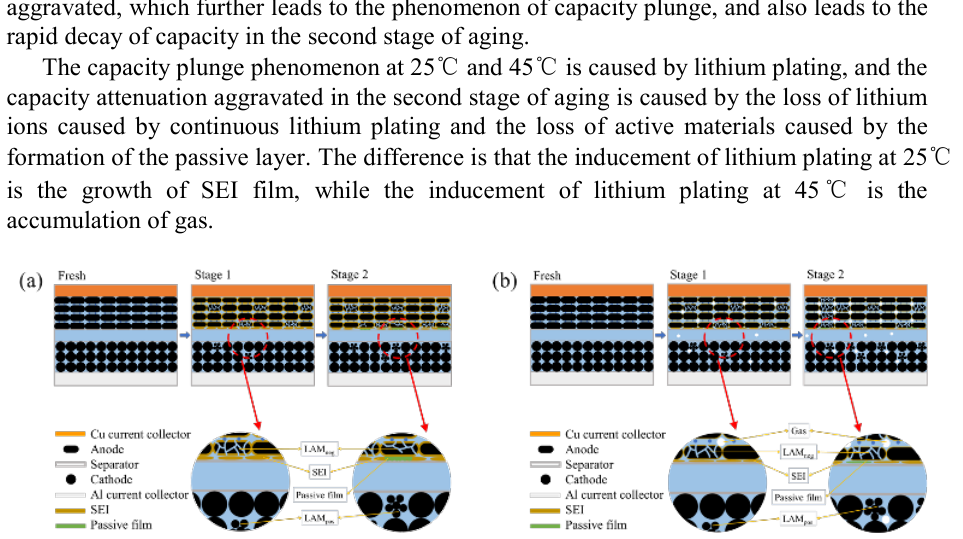
Fig. 6. The cycling degradation mechanism of battery at 25 ℃ (a), and 45 ℃